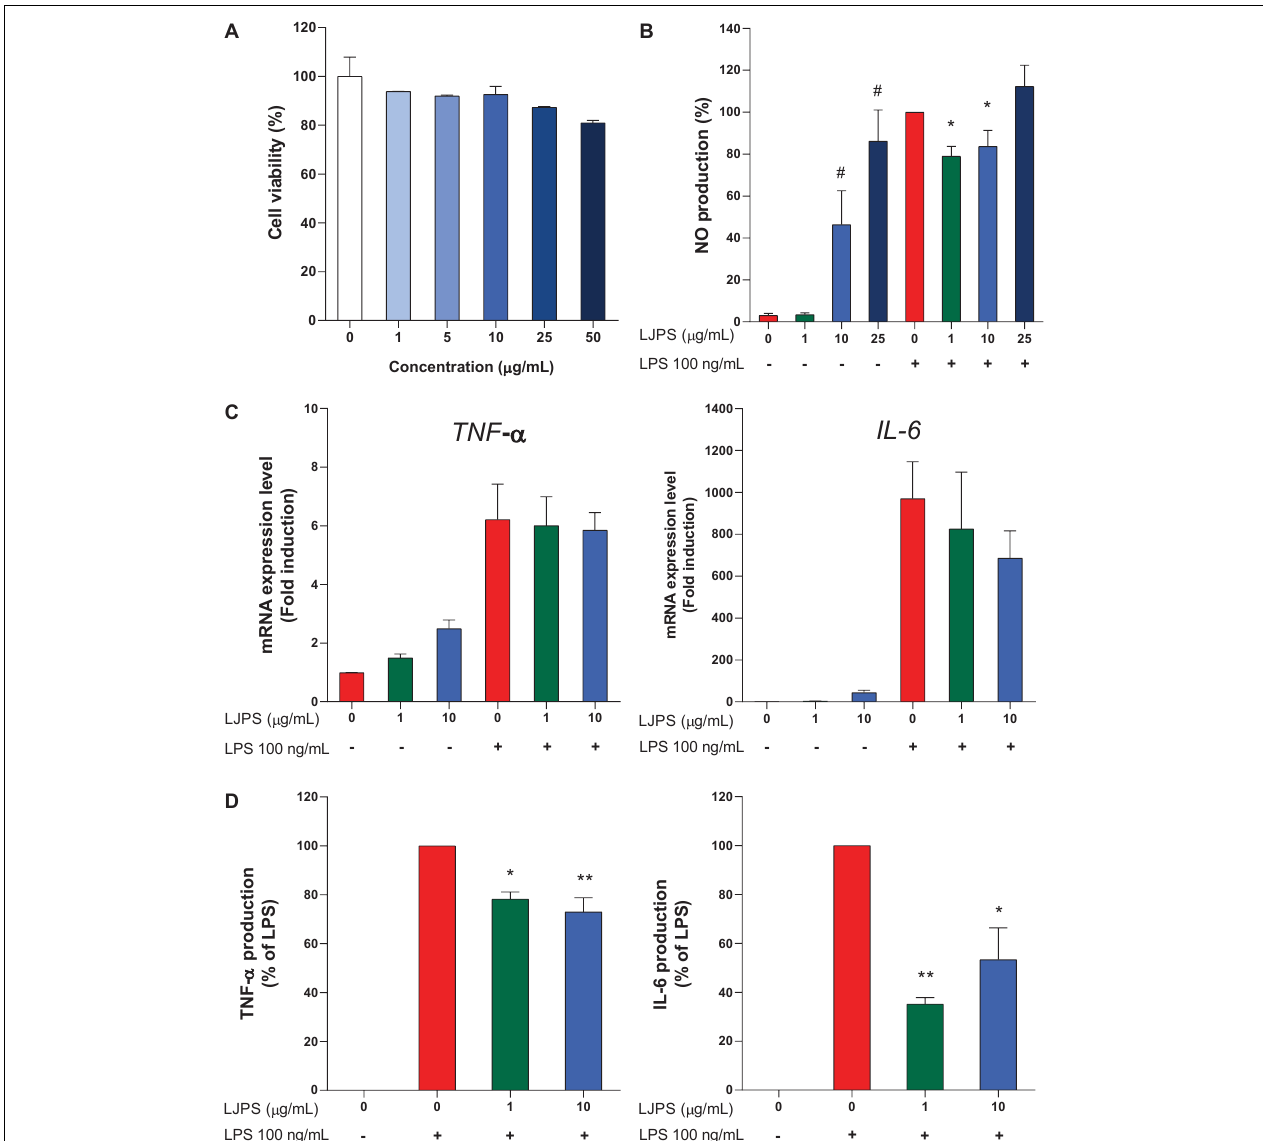
FIGURE 7 | Cellular toxicity and immunomodulating effects of LJPS in mouse macrophage RAW 264.7 cells. (A) The effect of LJPS on the viability of RAW 264.7 cells. RAW cells were treated with various concentrations of LJPS (0–50 µ g/ml) for 24 h. (B) The effects of LJPS on NO production with and without LPS stimulus in RAW 264.7 cells. RAW cells were starved overnight and pretreated with LJPS (1, 10, or 25 µ g/ml) for 6 h and then stimulated with LPS (100 ng/ml). Values are the mean ± SEM. # and * indicate a significant difference compared with that in the control without and with LPS stimulus, respectively ( p < 0.05). (C,D) RAW cells were starved overnight and pretreated with LJPS (1 or 10 µ g/ml) for 6 h and then stimulated with LPS (100 ng/ml). At the end of treatment, RNA and supernatants were collected to detect mRNA and protein expression of IL-6 and TNF- α . Values are the mean ± SEM of three independent experiments. * Indicates a significant difference (* p < 0.05, ** p < 0.01). LJPS, Laminaria japonica derived polysaccharide; LPS, lipopolysaccharide; NO, nitric oxide; TNF- α , tumor necrosis factor- α ; IL-6,